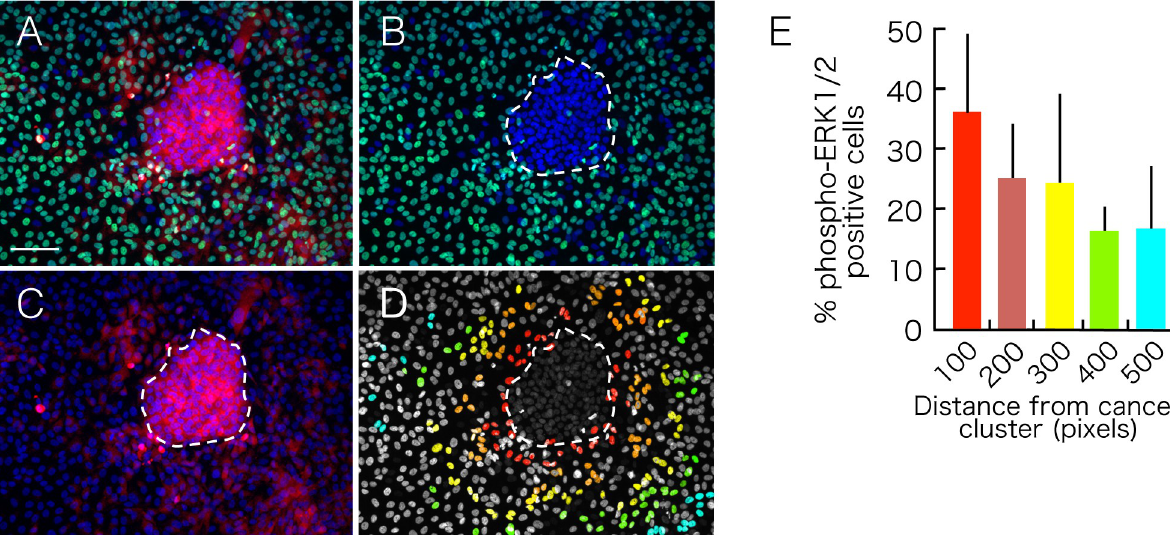
Fig 6. Analysis of region-specific phosphorylation of ERK1/2. ACT1 cell clusters were co-cultured with GFP-NTECs for 5 days, fixed with formaldehyde, and stained with anti-phosphorylated ERK1/2 antibody. (A) Merged image. (B) Green fluorescence image showing GFP-NTECs. Area designated with a white dashed line indicates ACT1 cell cluster. (C) Red fluorescence image showing phosphorylation of ERK1/2. (D) NTECs with phosphorylated ERK1/2 signals zoned according to their distance from the ACT1 cluster. Red cells are phosphorylated ERK1/2-positive within 100 pixels from the cluster, orange 100–200 pixels, yellow 200–300 pixels, green 300–400 pixels, cyan 400–500 pixels. Percentage of NTECs with phosphorylated ERK1/2 is indicated in (E). The bar in (A) indicates 100 μ m.